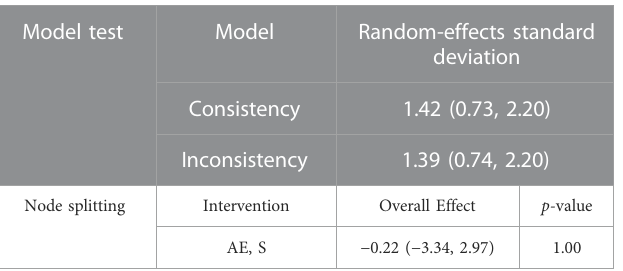
TABLE 2 The results of consistency tests and node splitting